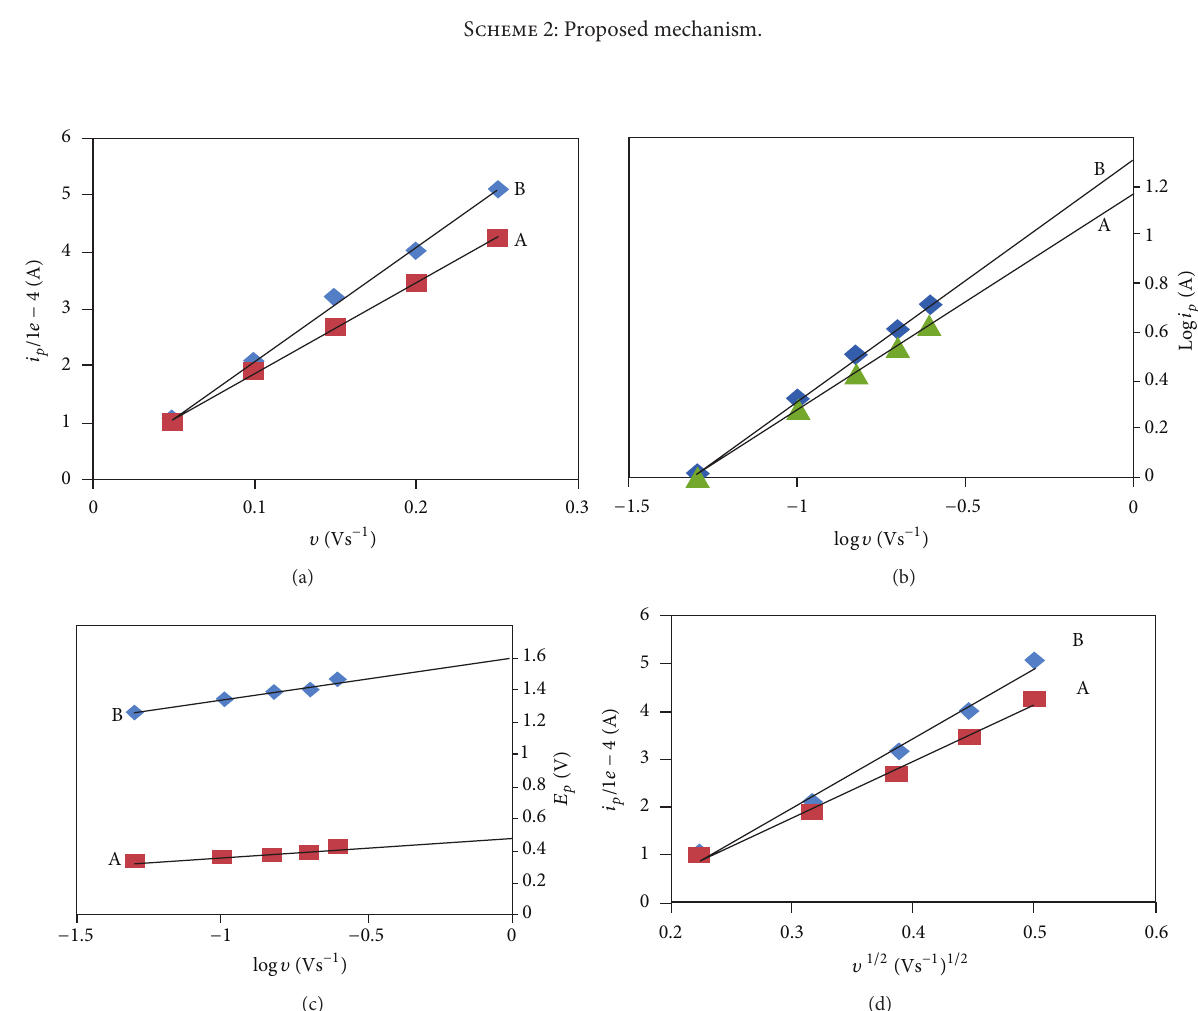
Figure 5: (a) Dependence of the oxidation peak current of peaks A and B on the scan rate. (b) Dependence of the logarithm of peak current on logarithm of scan rate for peaks A and B. (c) Relationship between peak potential and logarithm of scan rate for the peaks A and B. (d) Relationship between peak current of peaks A and B on the square root of scan rate.